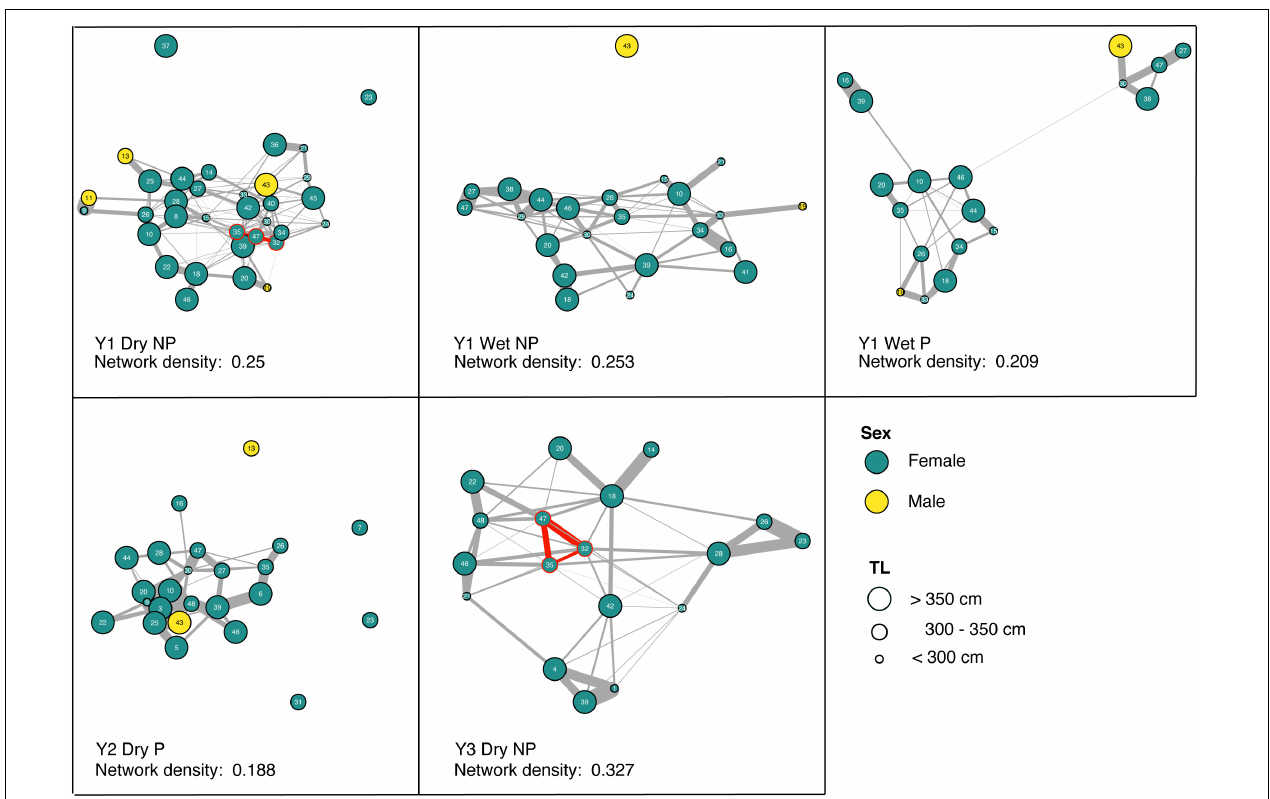
FIGURE 3 | Generalized Affiliation Indices (GAIs) indicating social preferences between tiger sharks within the five non-random social networks. Edge weight (gray) is indicative of the strength of social preference, while node color indicates sex and node size, the size class of the individual. Network density (0–1 scale) is reported illustrating the relative connectedness of the network, where 1 would indicate a network with all conspecifics preferentially associated with all others and 0, no social preferences exist at all. Red nodes and edges illustrate a particular triad of tiger sharks that preferentially socialize in both years 1 and 3.